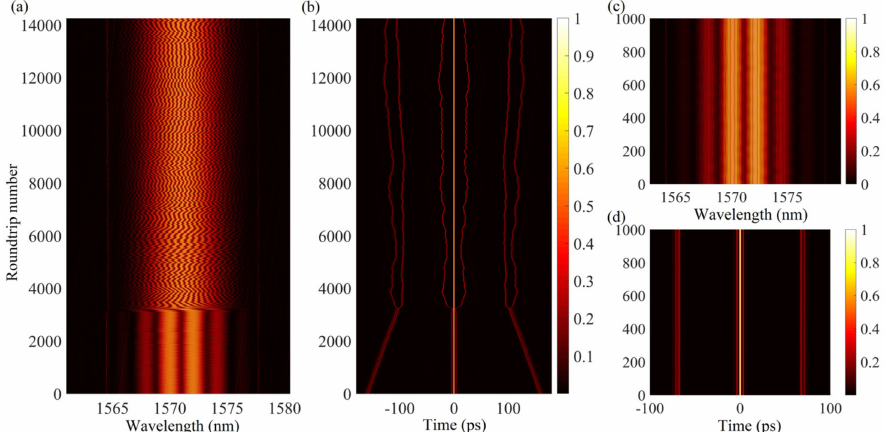
Figure 7. Formation of an unequally spaced soliton triplet. ( a ) The real-time spectral evolution measured by the DFT technique, ( b ) the corresponding field autocorrelation traces, ( c ) shot-to-shot spectra of the formed stabilized soliton triplet, and ( d ) the field autocorrelation traces of the stationary soliton